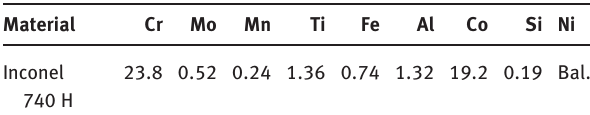
Table 1: Chemical composition of experimental material (mass fraction/%).